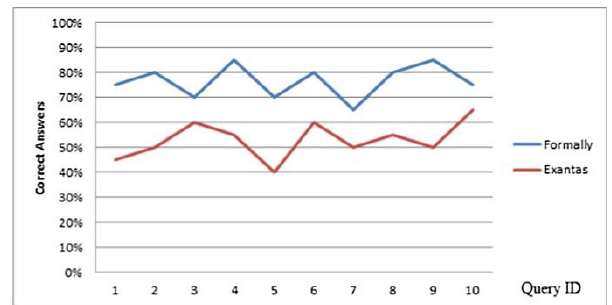
Figure 7. Queries results asked from teacher versus